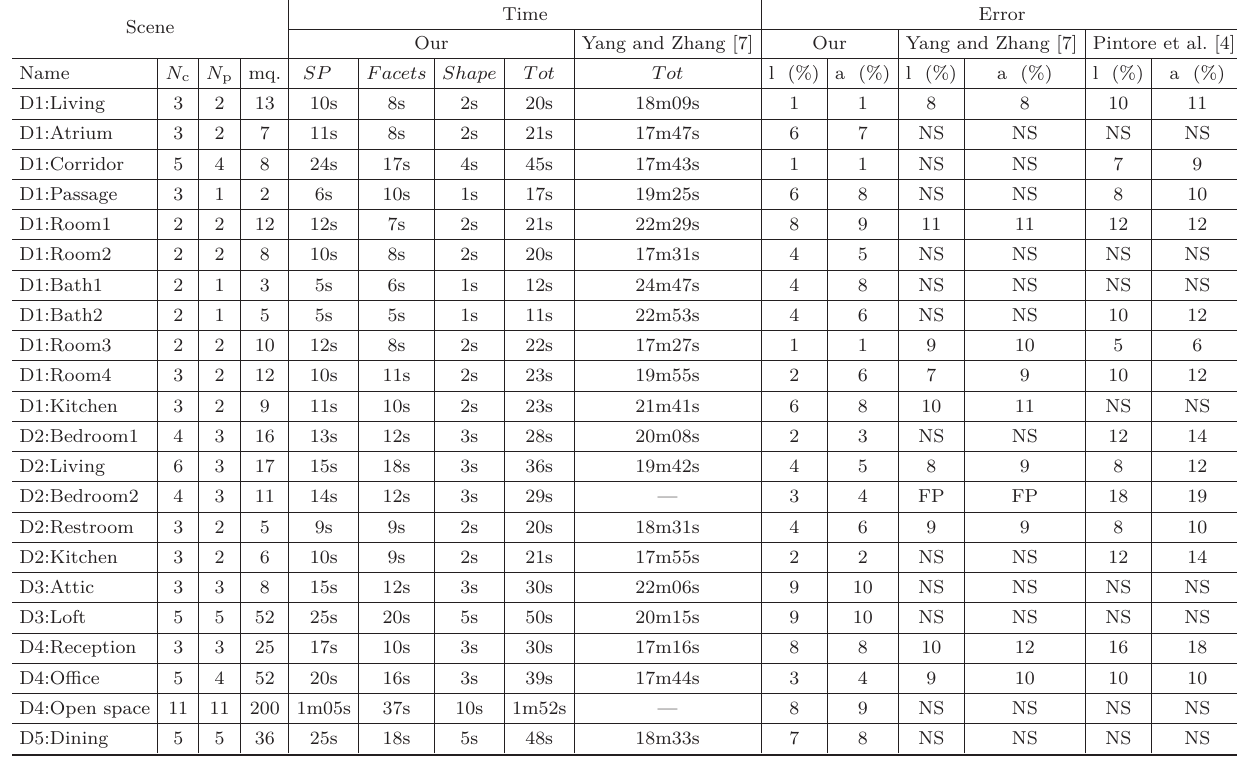
Table 1 Reconstruction performance for real-world multi-room environments, detailing results per room to allow comparison with single-view methods [4, 7]. N c : total number of images captured, including passages and connections, N p : number of images processed to obtain the shape, followed by the room area. SP : time to compute super-pixels. Facets : time to create labeled facets. Shape : time to combine facets and find the shape in world space. Tot : total time to compute the room model with our method, and those of Yang and Zhang [7] and Pintore et al. [4]. NS: no structure , i.e., the reconstruction failed to return a model comparable to the real ground truth structure. FP: failed processing